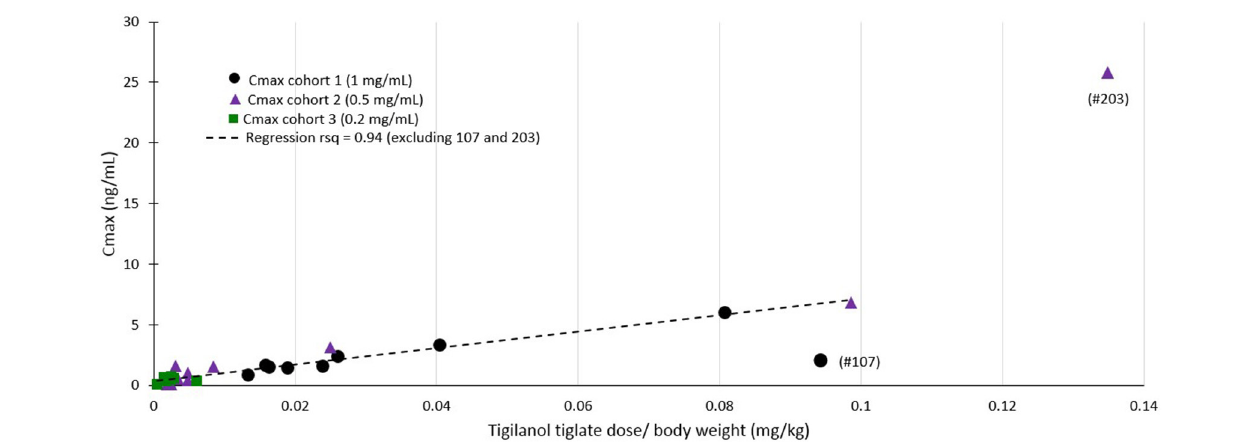
FIGURE 4 | Cmax vs. dose normalized by body